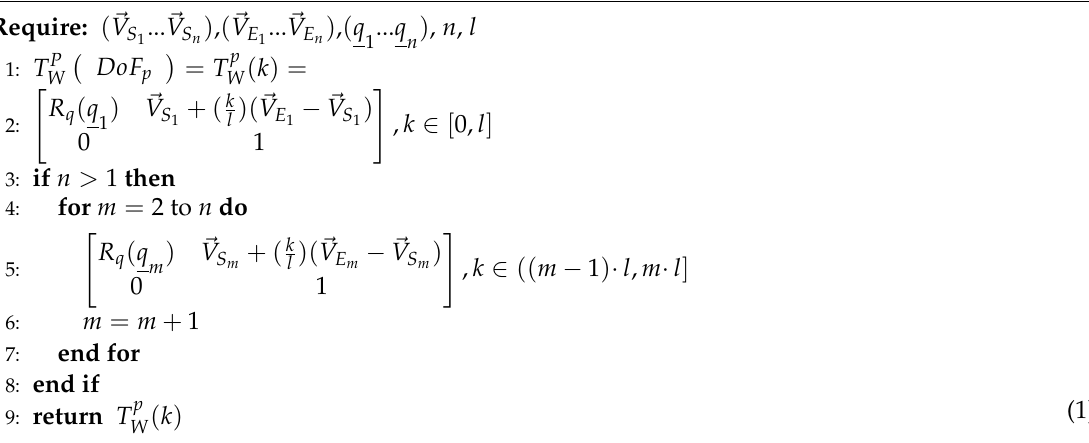
Algorithm 1 Algorithm for automatic interpretation of the multiple seam product